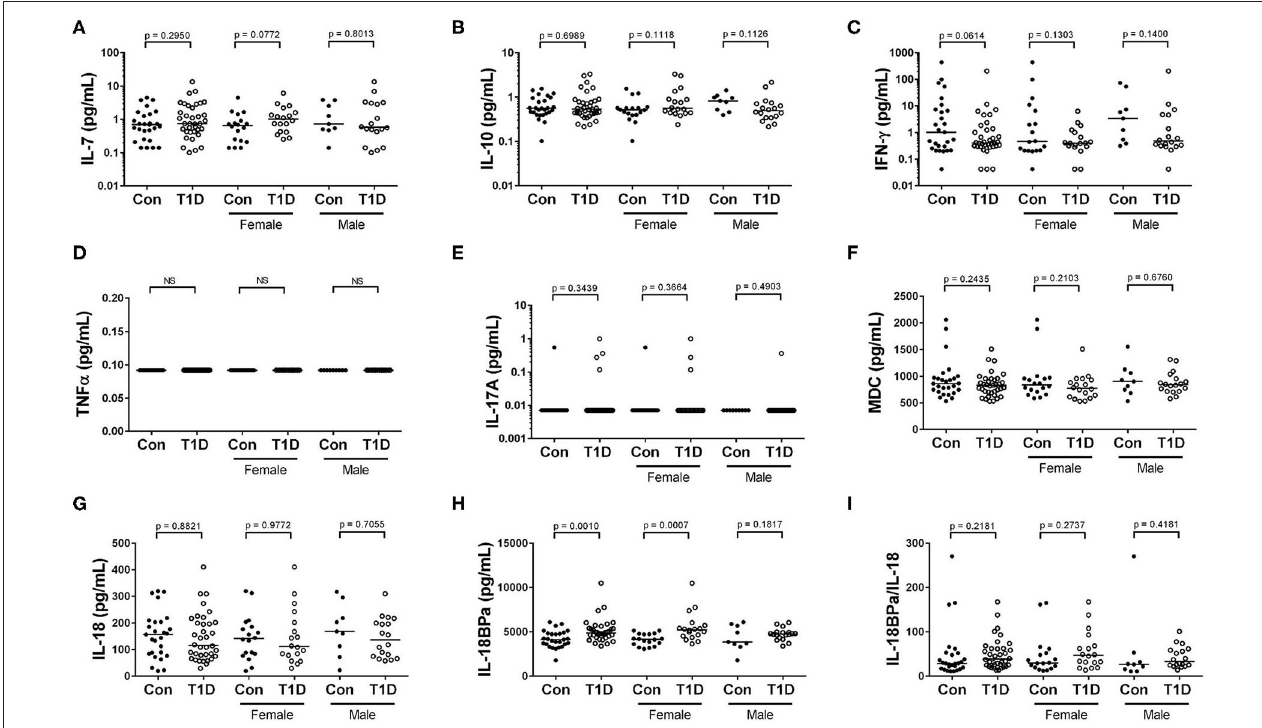
FIGURE 7 | Elevated IL-18BPa among T1D subjects, while other cytokines show similar abundance. (A–C) We observed that IL-7, IL-10, and IFN- γ levels were more-or-less similar among T1D subjects and controls. (D,E) . We were unable to detect TNF α and IL-17A in the majority of our subjects. (F) The chemokine macrophage derived chemokine (MDC) was similarly abundant among T1D subjects and controls. (G,H) While IL-18 levels were roughly equivalent between the two groups, elevated IL-18BPa levels were observed among the T1D group in relation to control. (I) Although IL-18BPa was elevated, the ratio of IL-18BPa to IL-18 was similar among T1D subjects and controls. Bars represent